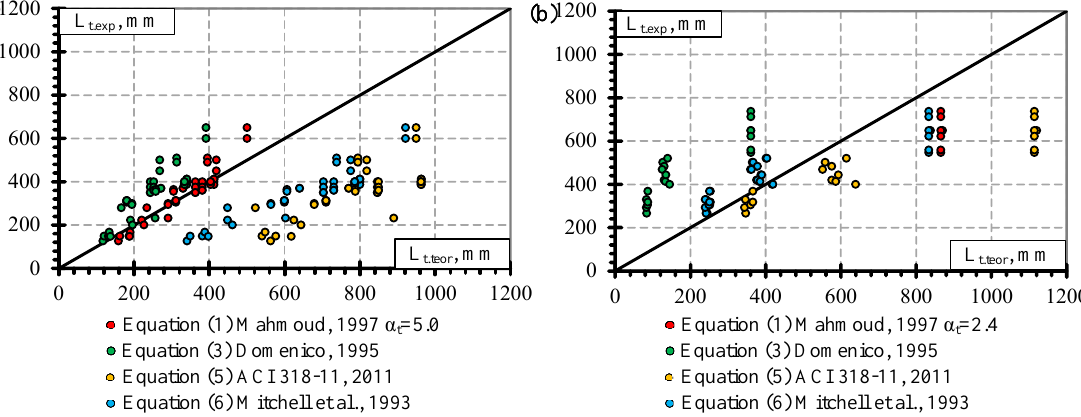
Figure 9. Relationship between experimental and theoretical transfer lengths of CFCC strands ( a ) for the gradual transfer of prestress, ( b ) for sudden transfer of prestress [30,31,63,64]. In the case of CFRP reinforcement (Figure 8b), Equation (3) gives the most inappropri- ate results with an underestimation of the experimental results by 70% (L t,teor /L t.exp = 0.30) with STD = 0.12, COV = 40.2%. Equation (6) also underestimates the experimental re- sults with L t,teor /L t.exp = 0.82, STD = 0.28, COV = 34%, but Equation (5) overestimates the results with L t,teor /L t.exp = 1.17, STD = 0.55, COV = 47.2%. Despite the relatively high variation of the results the most accurate prediction of experimental results was received by Equation (1) ( α t = 1.9) with L t,teor /L t.exp = 1.01, STD = 0.33, COV = 32.5%. Figure 9 distinguishes the comparison of experimental and theoretical results of the transfer length of CFCC strands for the gradual (Figure 9a) and sudden (Figure 9b) types of prestressing release. Equation (5) significantly overestimates the experimental results for gradual transfer of prestress with L t,teor /L t.exp = 2.31, STD = 0.81, COV = 35% (Figure 9a). Additionally, Equation (5) gives the same trend of the results for sudden transfer of prestressing with L t,teor /L t.exp = 1.41, STD = 0.30, COV = 21.3% (Figure 9b). However, Equation (3) significantly underestimates the experimental results for both gradual (Figure 9a) and sudden (Figure 9b) prestress transfer with L t,teor /L t.exp = 0.69, STD = 0.19, COV = 27.2% and L t,teor /L t.exp = 0.38, STD = 0.14, COV = 37%, respectively. Despite the low precision (L t,teor /L t.exp = 1.84, STD = 0.48, COV = 25.9%) in predicting the transfer length for the gradual transfer of prestress (Figure 9a), Equation (6) presents